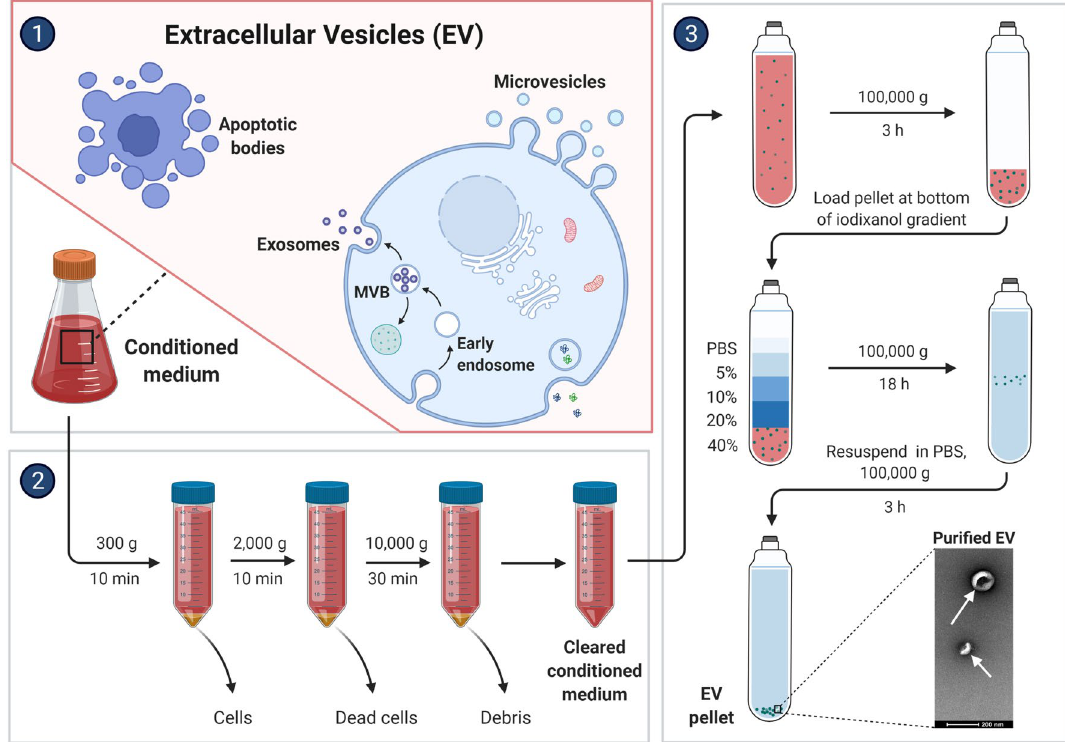
Fig. 1 Example of protocol to isolate and purify EVs from conditioned cell culture media. Large EVs (macrovesicles, apoptotic bodies, and oncosomes) derive directly from the extrusion of plasma membranes. Small EVs (also called exosomes) are produced in the multivesicu- lar bodies (MVBs) that are then secreted in the extracellular space, fusing with the plasma membrane. Density gradient ultracentrifugation protocol to isolate EVs involves centrifuging conditioned cell culture media at different speeds ranging from 300 to 10,000 g for 10–30 min, then ultra centrifuging at 100,000 g for 3 h. The EV pellets are then ultracentrifuged for 18 h at 100,000 g on an iodixanol gradient to be puri- fied. The pellets containing purified EVs are then resuspended in PSB to be washed ultra centrifuging at 100,000 g for 3